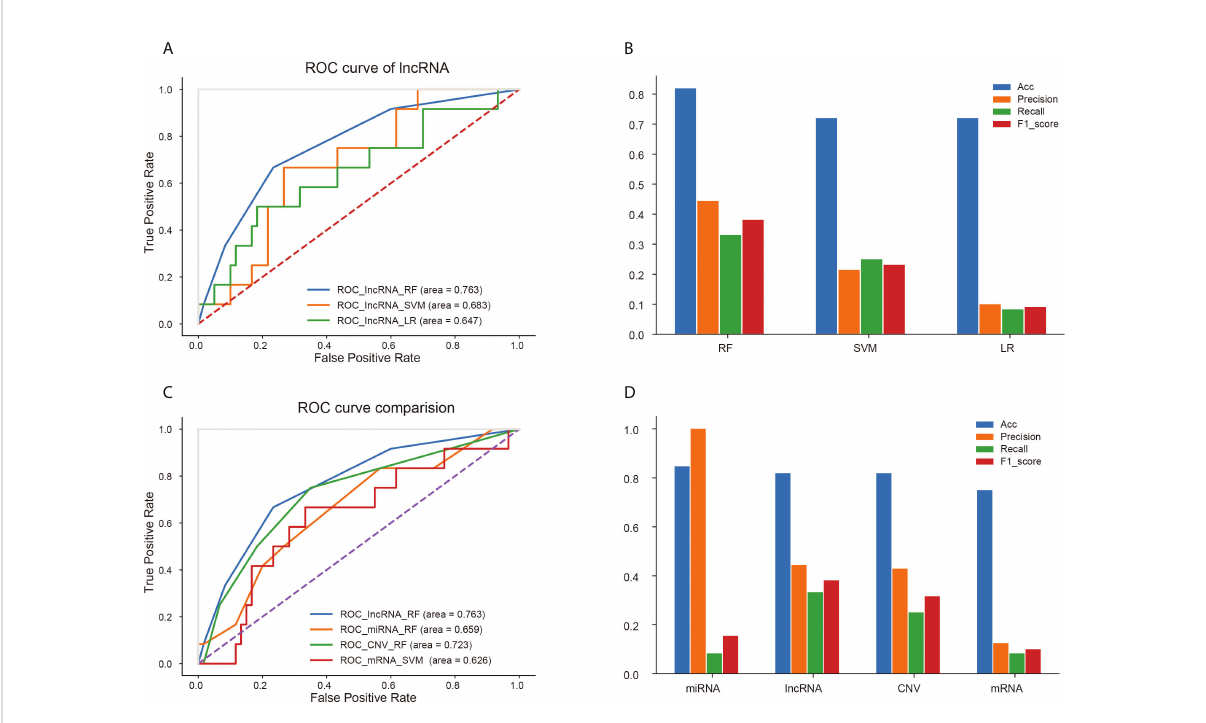
FIGURE 5 Prediction performance of different models based on four kinds of omics data. (A) ROC curves of three models based on lncRNA data. (B) Accuracy, precision, recall and F1-score of three models for lncRNA signatures. Comparison of ROC curves (C) and four properties (D) of optimal models based on four kinds of omics